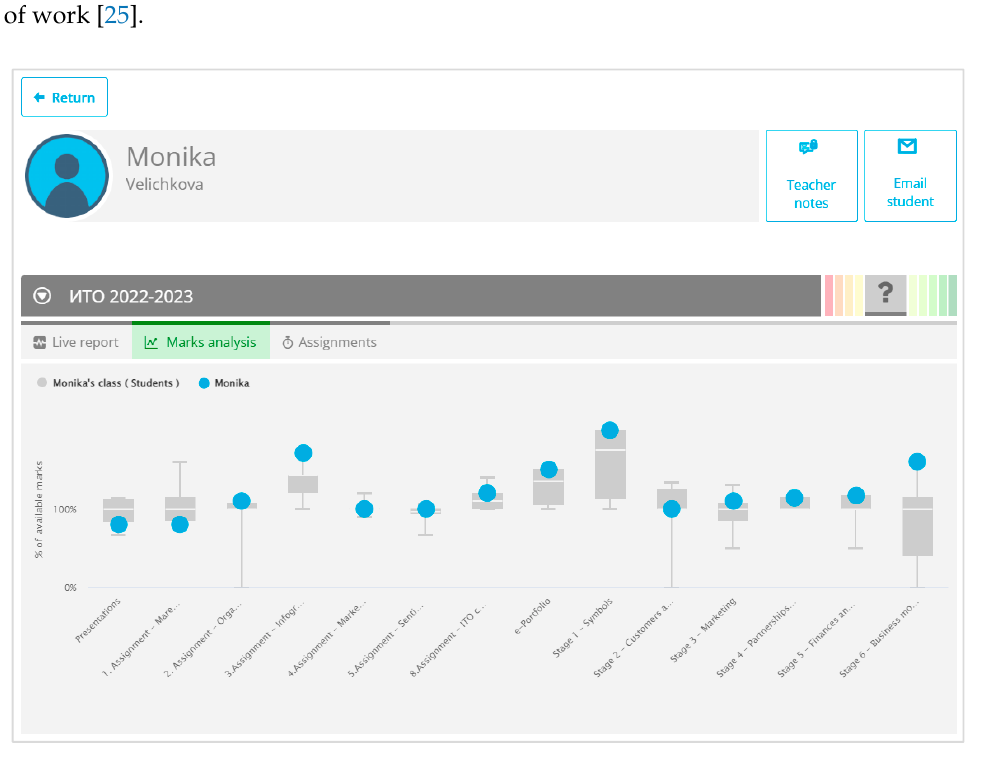
Figure 4. Stile dashboard “Individual Mark book” (Screenshot of a student portfolio).